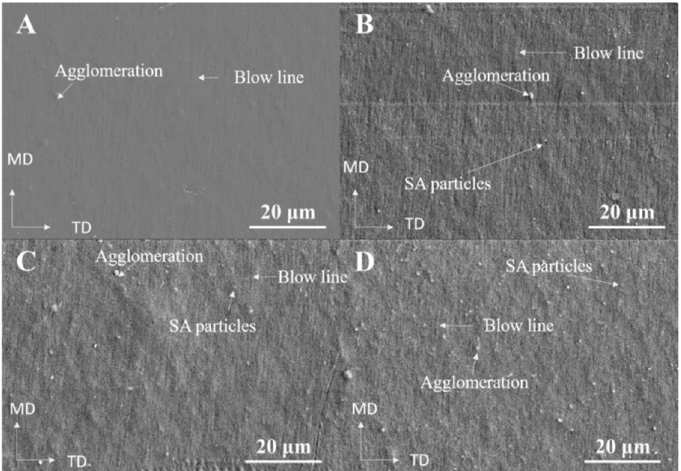
Figure 2. The field-emission scanning electron microscopy (FE-SEM) images of the LDPE/LLDPE blend polymer film with various SA contents: ( A ) 0 wt.%, ( B ) 0.5 wt.%, ( C ) 1 wt.%, and ( D ) 1.5 wt.% (MD = machine direction and TD = transverse direction).